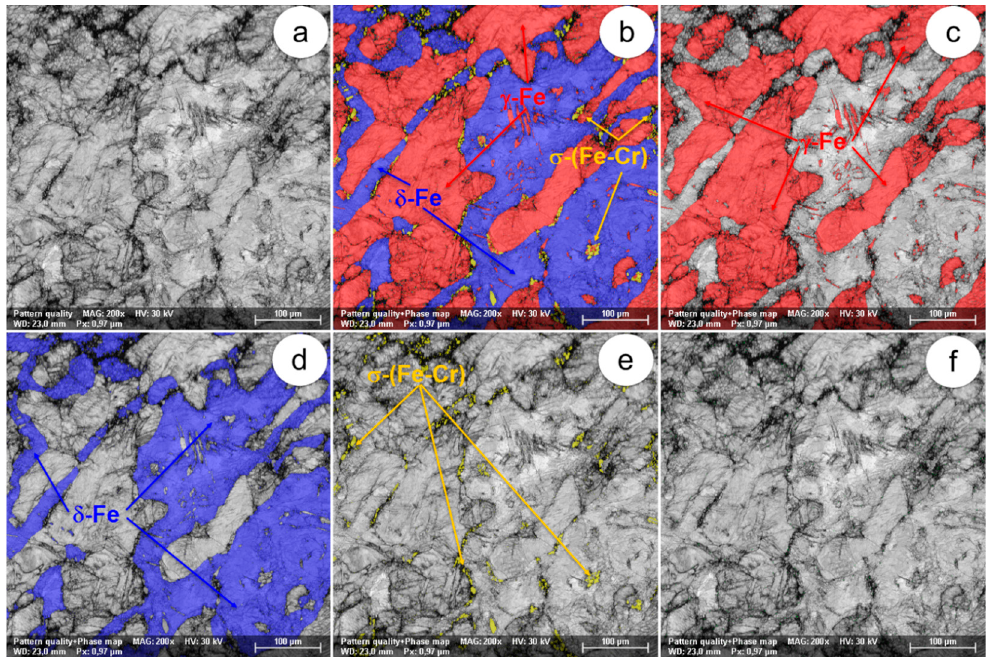
Figure 10. The SEM-EBSD composite images (×200) obtained after forging at 950 °C: ( a ) the microstructure of the analysed field; ( b ) the distribution of existing phases in the microstructure of the analysed field; ( c ) the distribution of the γ -Fe phase; ( d ) the distribution of the δ -Fe phase; ( e ) the distribution of the σ -(Fe-Cr) phase; ( f ) the distribution of the χ -(Fe-Cr-Mo) phase.